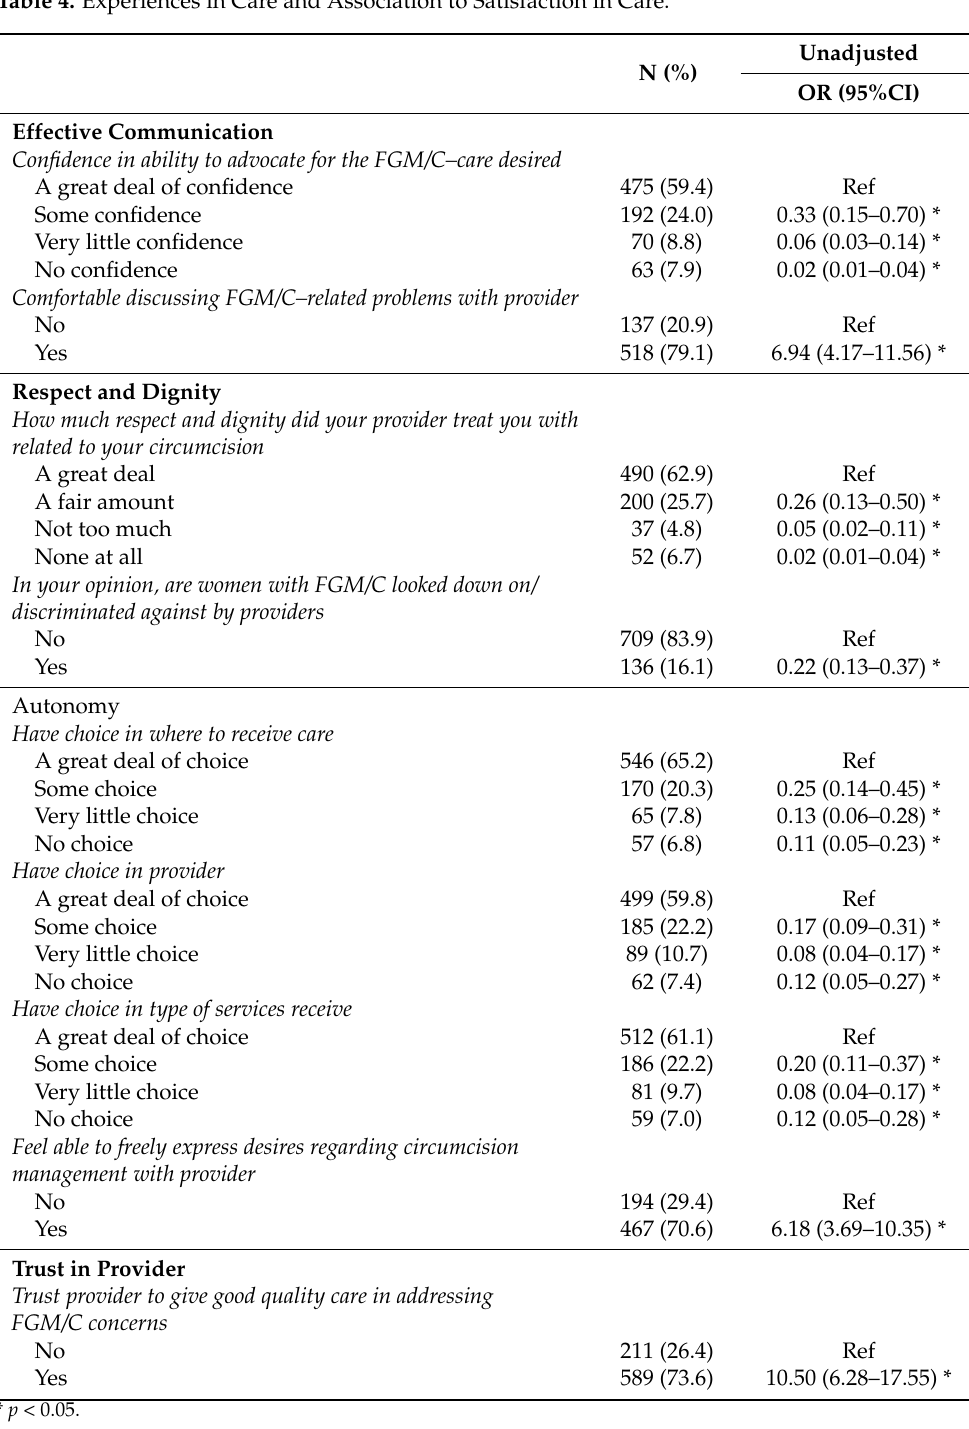
Table 4. Experiences in Care and Association to Satisfaction in